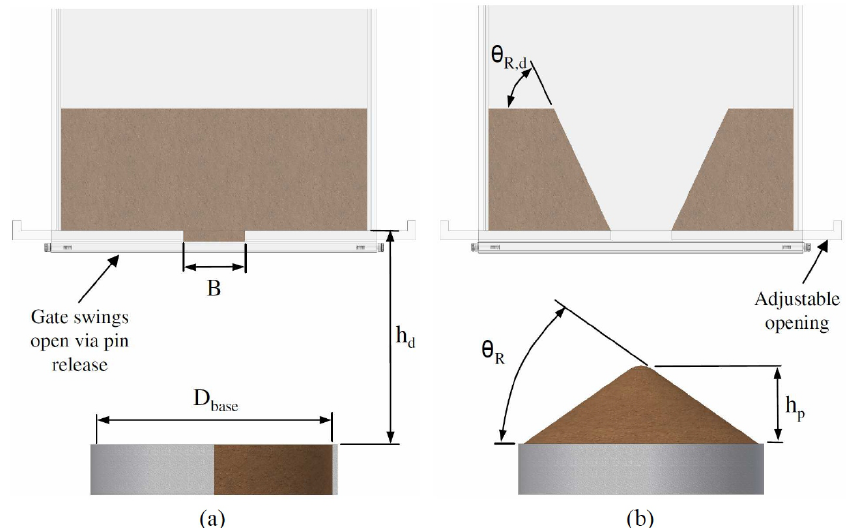
Figure 18. Discharge from a flat-bottomed hopper by [64], showing ( a ) the initial configuration with all of the material in the hopper, and ( b ) the discharged configuration with the heap at the bottom forming and remaining material in the hopper. Reproduced with permission from A.